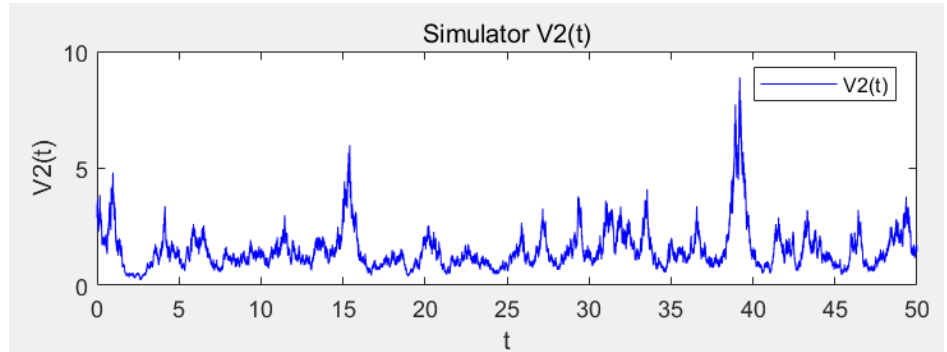
Figure 3. Sample path of V2(t).